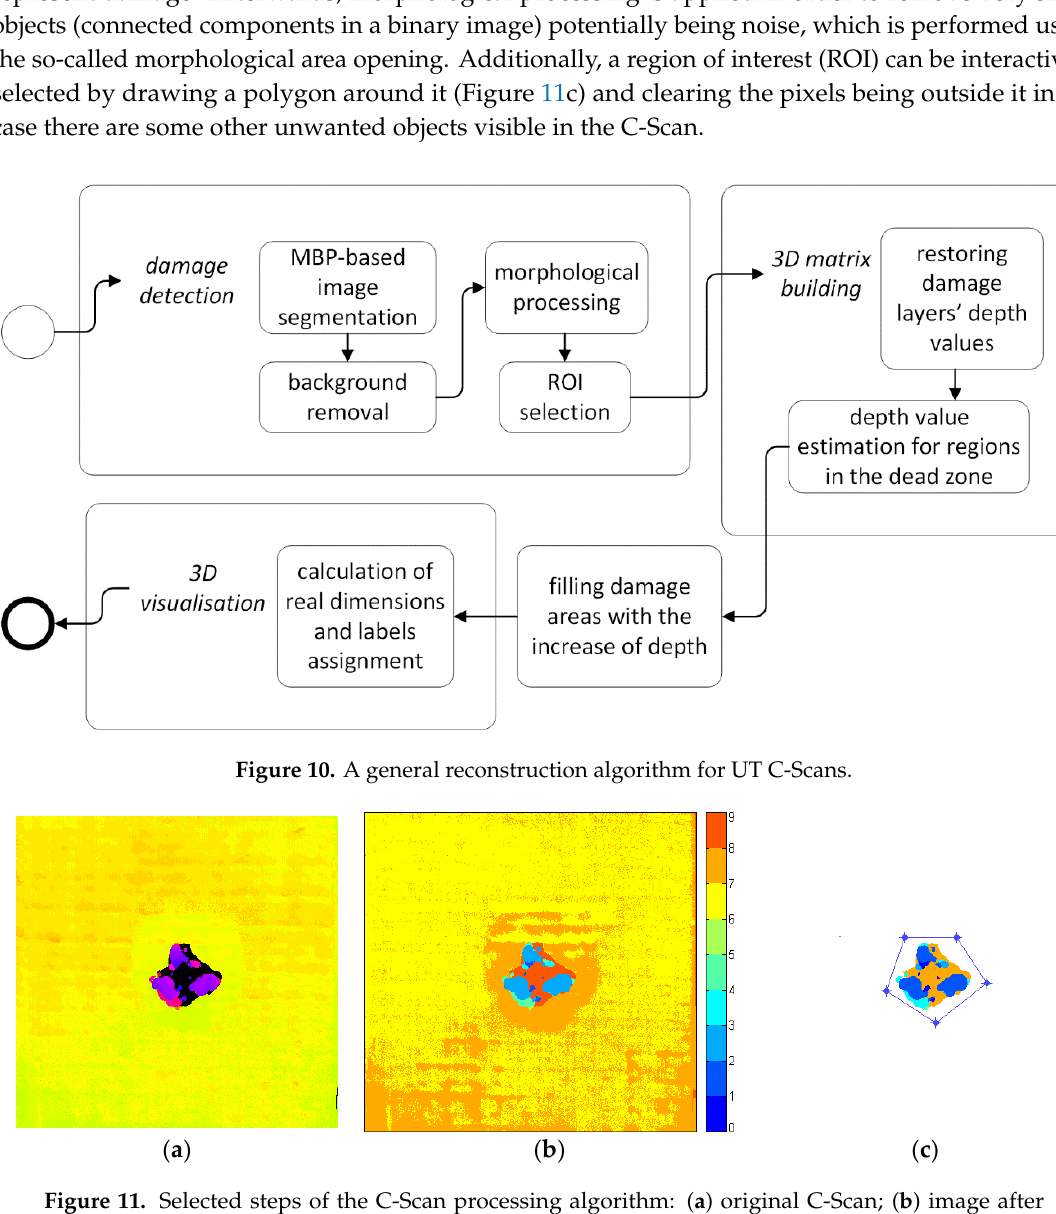
Figure 11. Selected steps of the C-Scan processing algorithm: ( a ) original C-Scan; ( b ) image after segmentation; ( c ) ROI selection after the background removal.